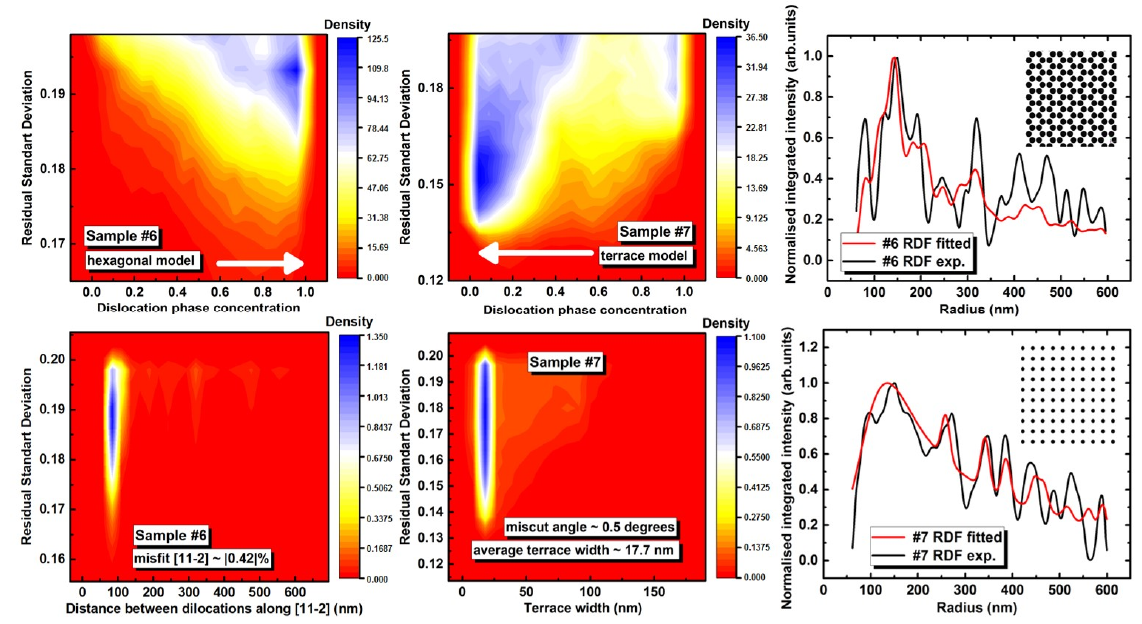
Figure 10. Dependence of 2D kernel density of residual standard deviation on random uniform distribution of sets fitting parameters of the autocorrelated RDF for both samples: ( upper left ) weight of pore distribution model (hexagonal or 1 × 1 square lattice or terrace), ( lower left ) distance between the dislocation along [11 − 2], sample #6; ( middle-upper ) weight of pore distribution model (hexagonal or terrace), ( middle-lower ) distance between average terrace width, sample #7; ( upper right ) the autocorrelated RDF fitted for the sample #7, ( right lower ), the autocorrelated RDF fitted for the sample #6; insets show the pore distribution